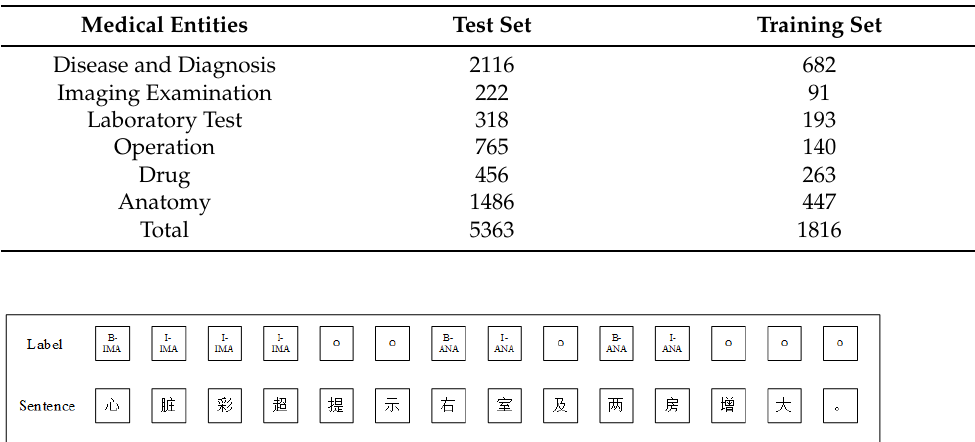
Figure 3. Example diagram of data annotated by BIO. (The example sentences: Cardiac ultrasound indicates right ventricular and biventricular enlargement. “B-IMA” indicates that the element is in a segment of the entity type Imaging Examination, and that the element is at the beginning of the segment. “I-IMA” means that the element is in a segment of entity type Imaging Examination and the element is in the middle of the segment. “O” indicates that the element does not belong to any